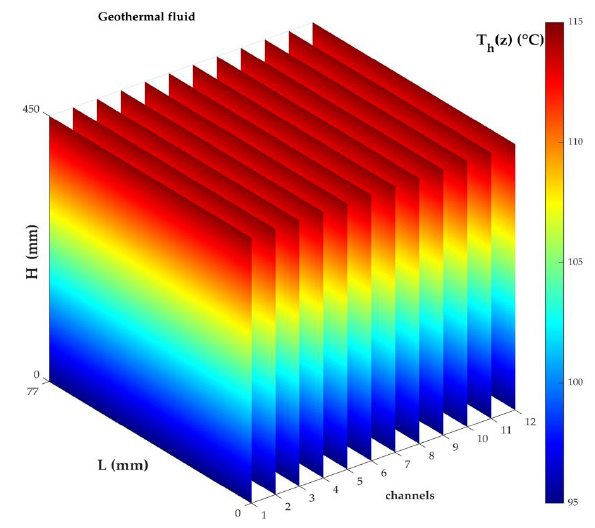
Figure 6. Temperature trend of hot geothermal fluid for Nc = 12 and 𝑇 ℎ,𝑖𝑛 = 115 °C.